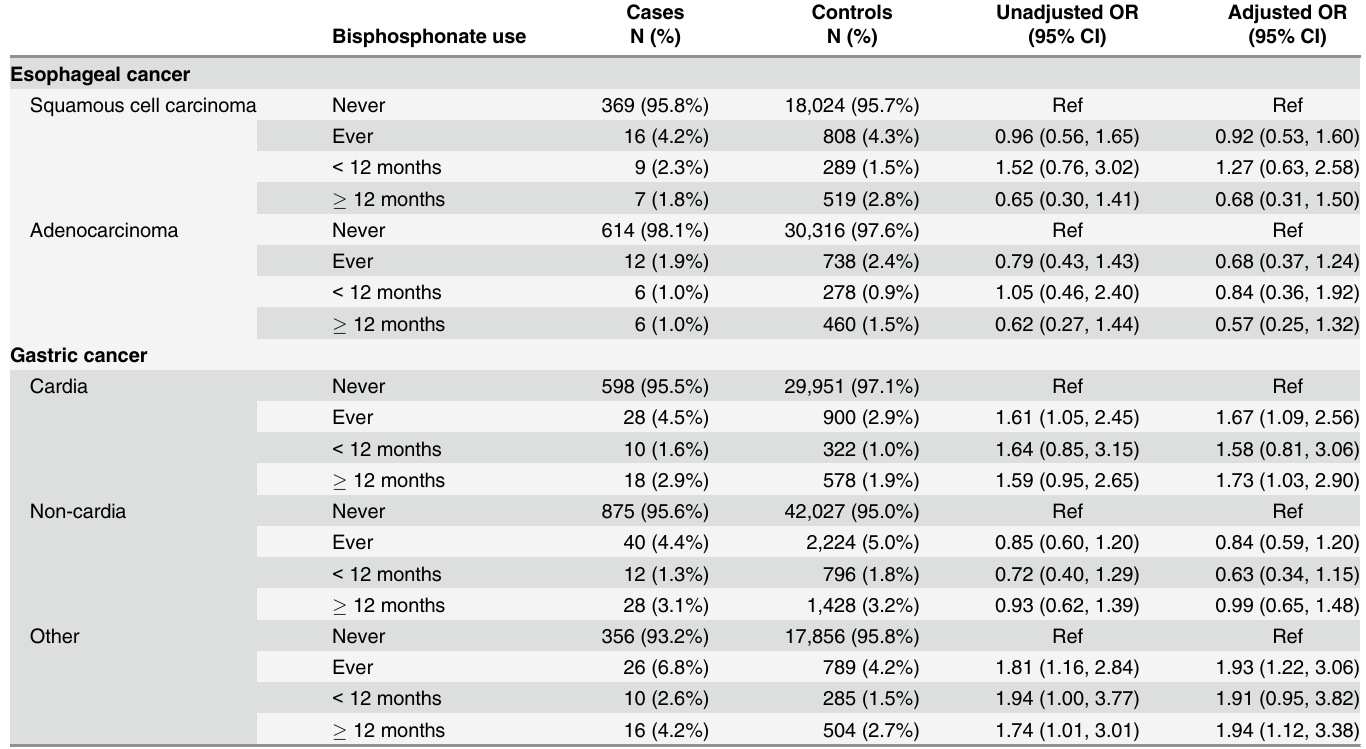
Table 2. Conditional logistic regression for the associations between oral bisphosphonates and esophageal or gastric cancer in Kaiser Perma- nente, Northern California, 1997 –